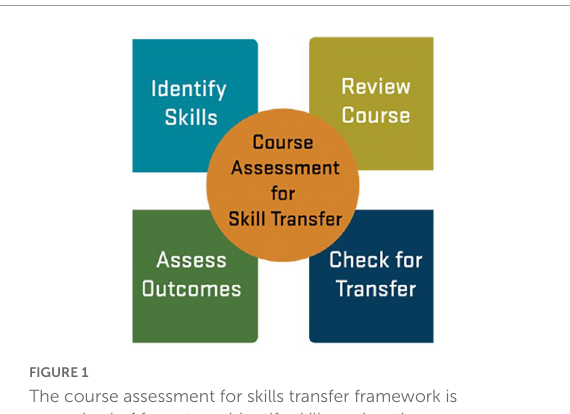
FIGURE1 The course assessment for skills transfer framework is comprised of four steps: identify skills, review the course, assess outcomes, and check for